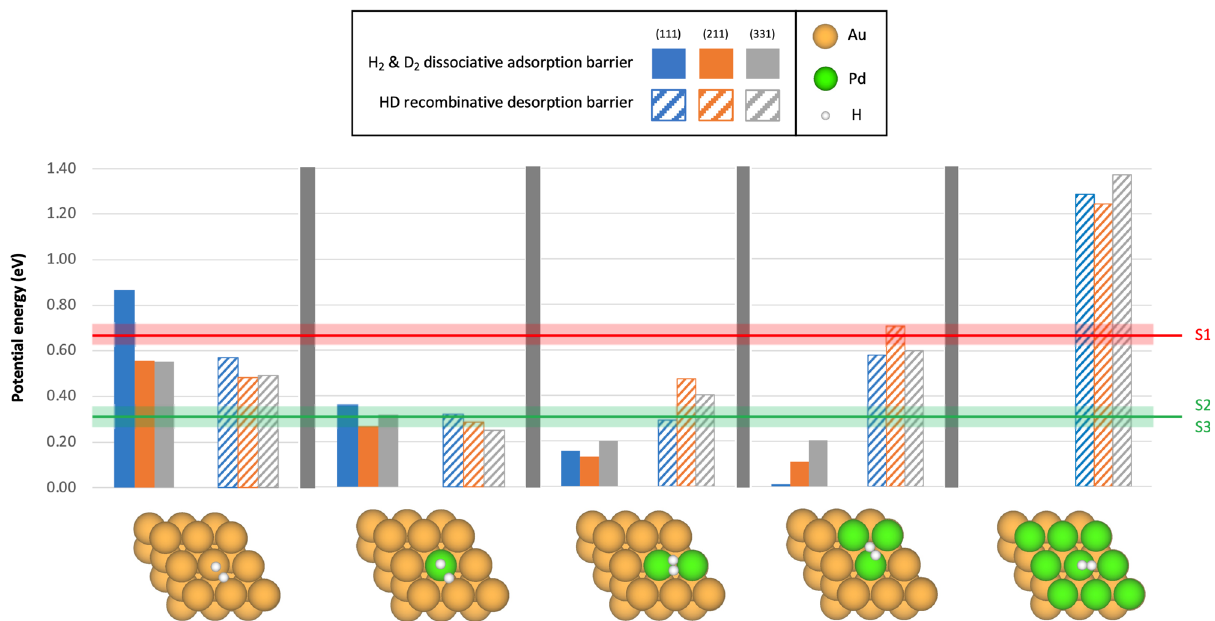
Fig. 3 DFT modeling establishes the Sabatier optimum with dilute Pd ensembles. Three close-packed facets are considered: (111) for terrace; (211) and (331) for step edges. Five model surfaces are considered: pure Au, Pd monomer, dimer, trimer, and Pd monolayer. As indicated by the plotted energy barriers, there is a trade-off between H 2 /D 2 dissociative adsorption ( fi lled) and HD recombinative desorption (hatched) with increasing surface Pd content. Horizontal lines indicate experimentally measured apparent activation energies with uncertainties over shaded regions: the values for sample S1 (O 2 - treated) and S2/S3 (H 2 -treated) agree well with those computed for the Pd trimer and monomer/dimer, respectively. All DFT-computed values have an uncertainty of 0.05 eV.